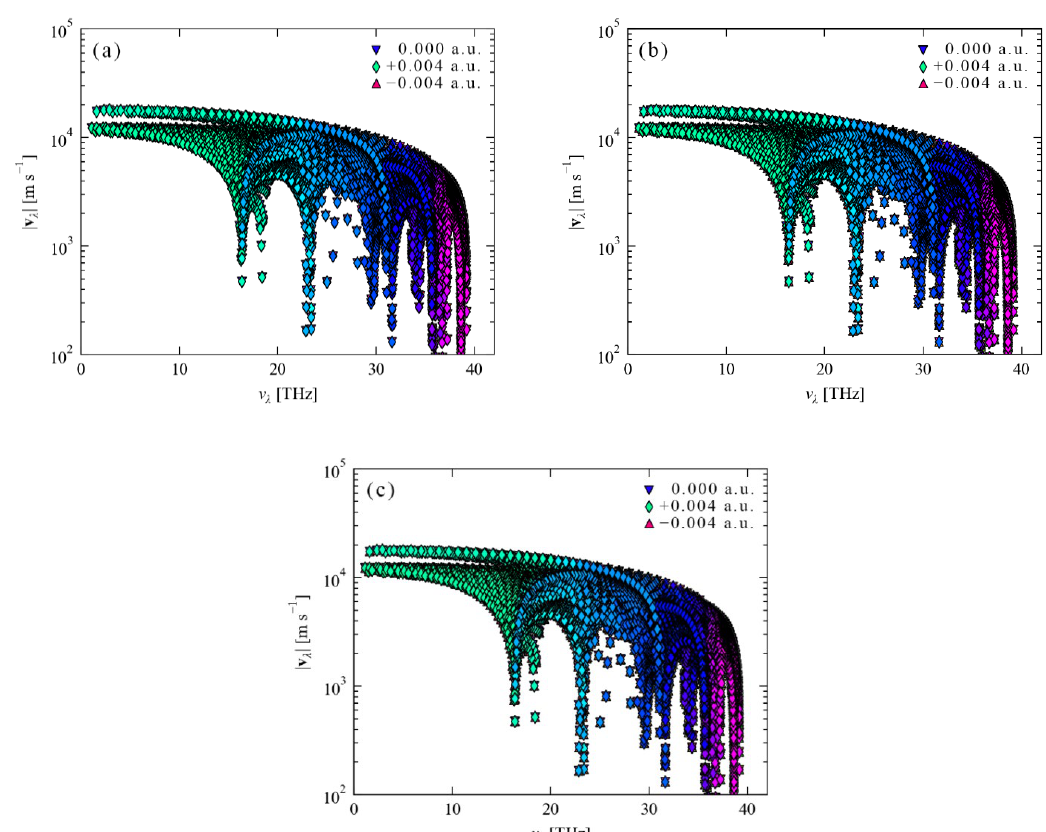
Figure 15. Phonon group velocities after applying ± 0.004 a.u. electric field in diamond [001], [110] and [111] crystallographic orientations. Among them, ( a ) an electric field is applied in the [001] crystallographic direction, ( b ) an electric field is applied in the [110] crystallographic direction and ( c ) an electric field is applied in the [111] crystallographic direction.